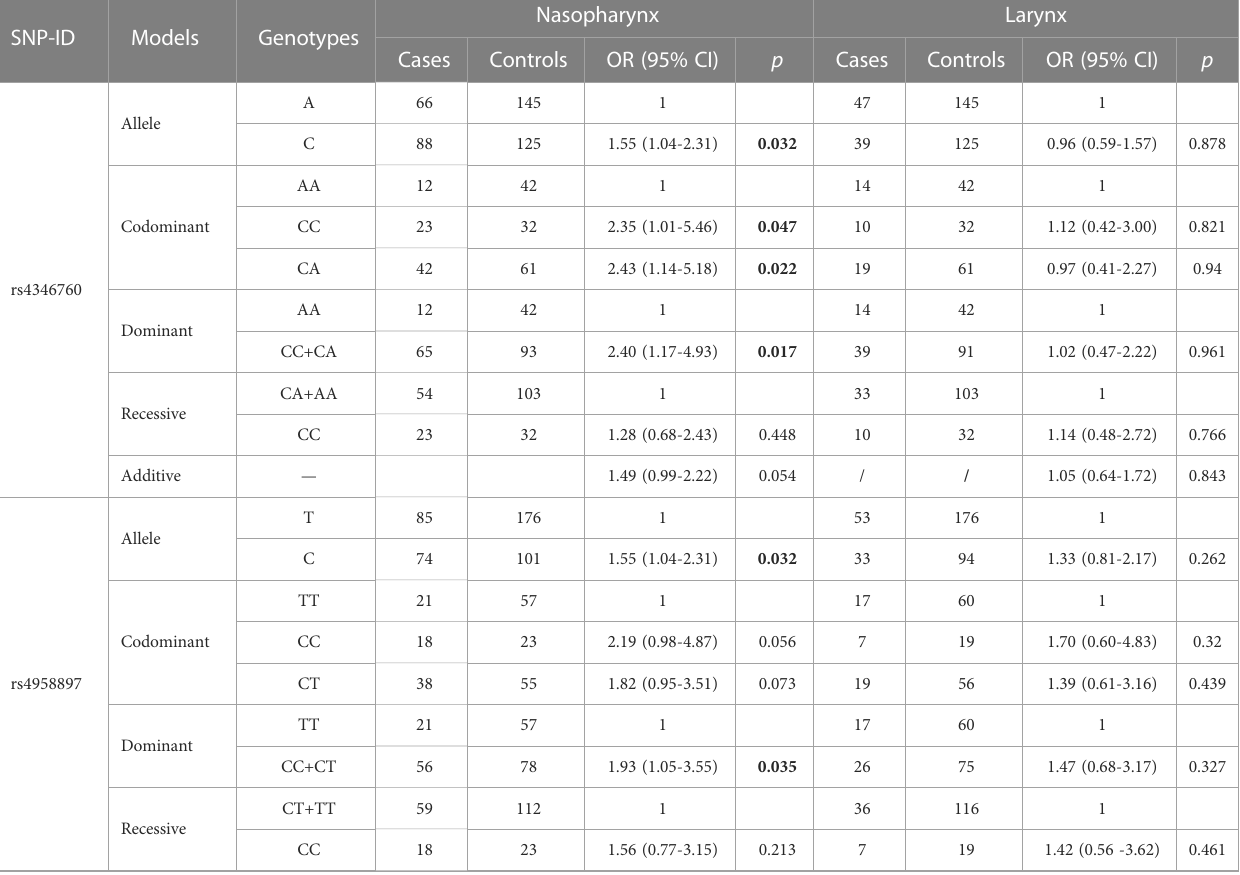
TABLE 5 Association of ANXA6 polymorphisms and HNC risk strati fi ed by tumor sites.